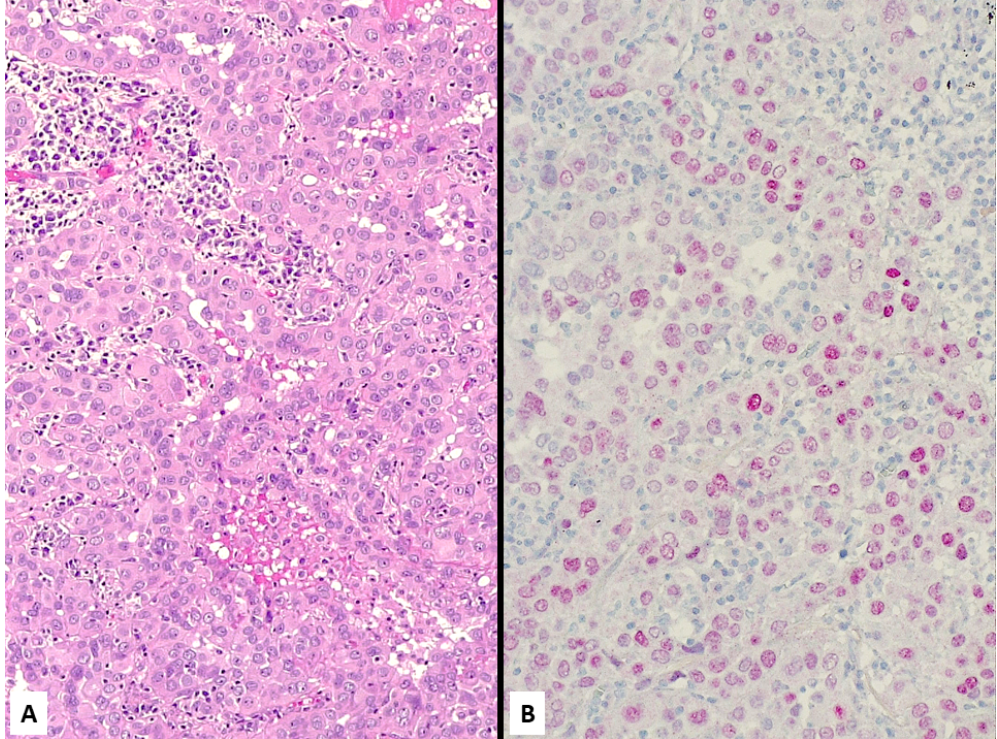
Figure 11. Epithelioid malignant mesothelioma ( A ) aberrantly showing nuclear expression of TTF-1 (clone SP141). ( B ).